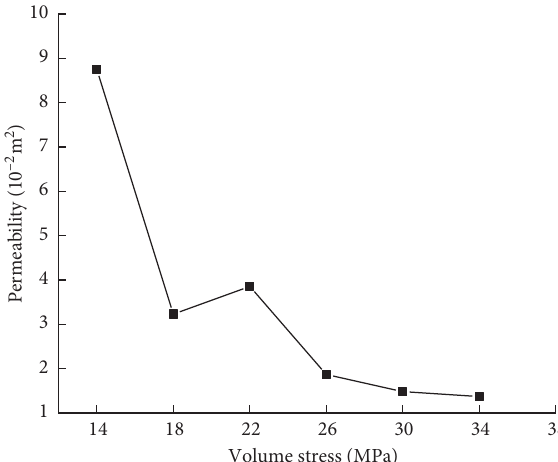
Figure 7: The curve of permeability versus volume stress.